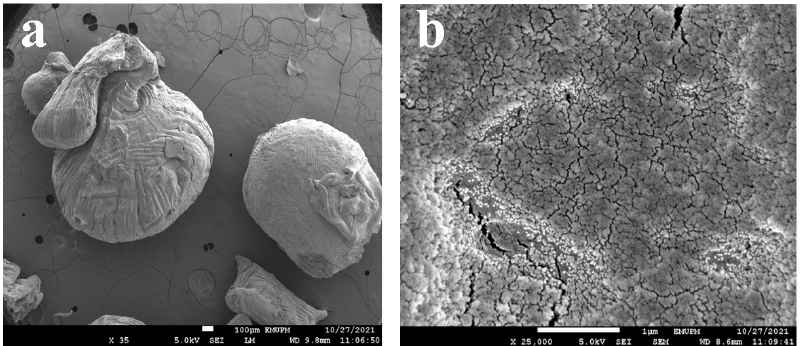
Figure 3 . FESEM images of SA −β− CD/CNTs before adsorption at different magnifications of ( a ) 35 Figure 3. FESEM images of SA − β − CD/CNTs before adsorption at different magnifications of ( a ) 35 × X ( b ) 25,000 X . ( b ) 25,000 ×